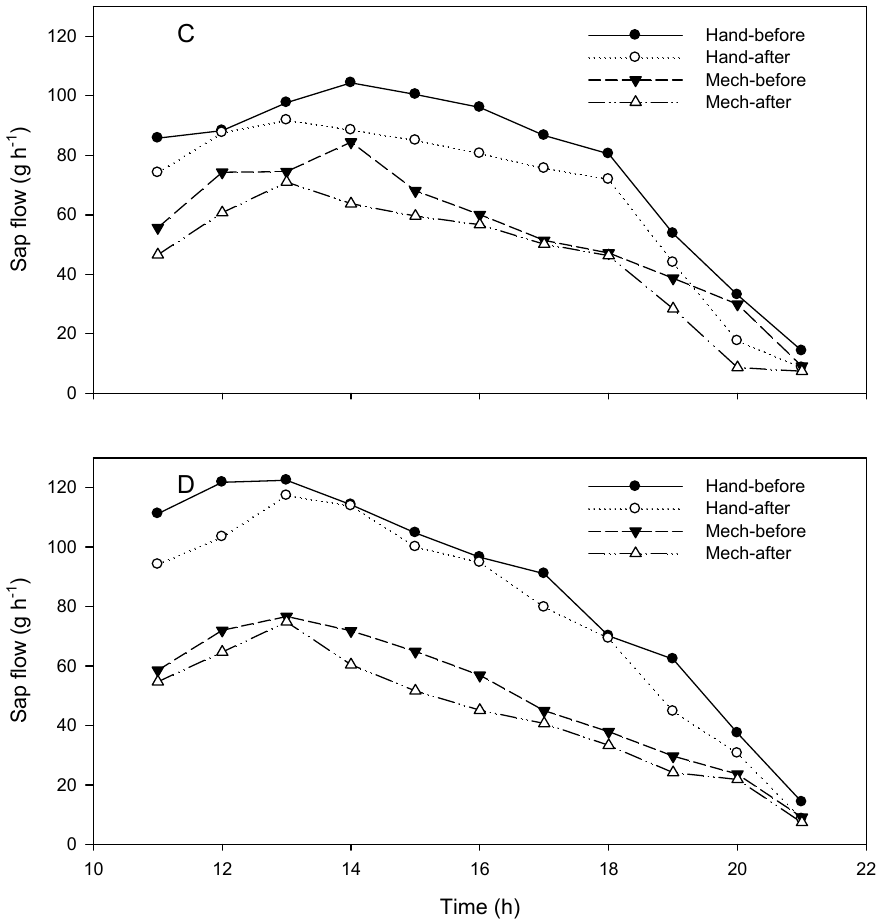
Figure 3. Effect of harvesting methods (Hand and mechanical canopy shaker) on hourly sap flow measurements in ( C ) and ( D ) experiments before and after harvesting respectively at the commercial site in southwest Florida during 2016.